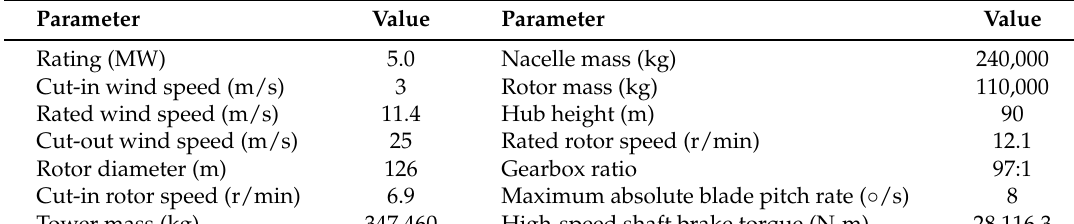
Table 1. 5 MW wind turbine specification.